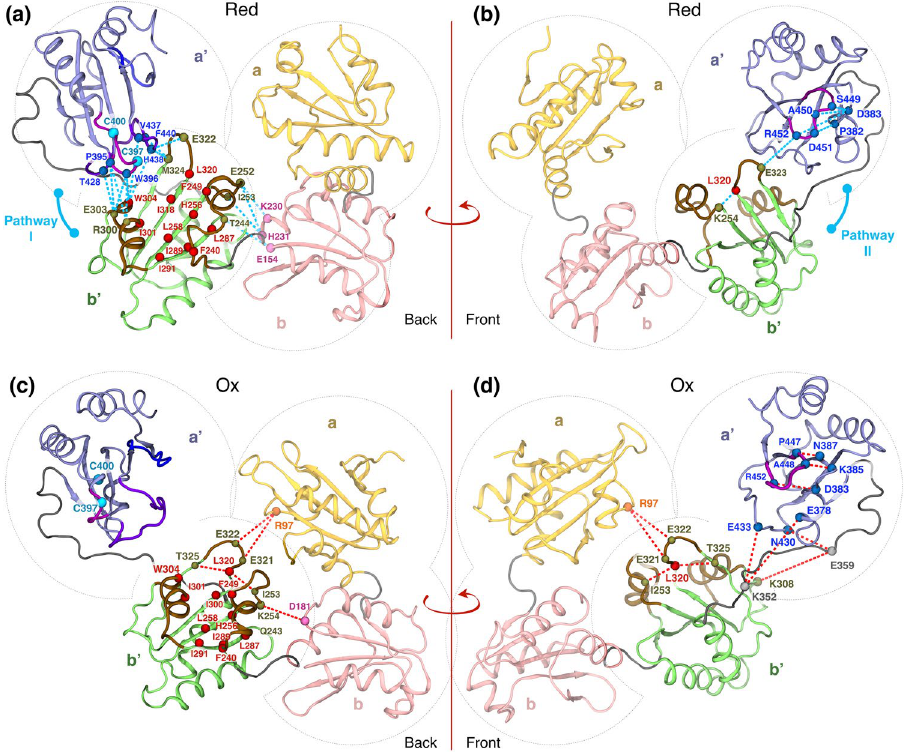
Figure 8. Red- ( a and b ) and ox- ( c and d ) dominated residue-residue interaction networks on two representative conformations of red- and ox-hPDI (C3 and C6 of FEL) between the b’ and a’ domains. Residues (C α ) within the hydrophobic pocket in each state are colored in red. Red and blue dash-lines indicate the ox- and red-dominated interactions, respectively. Secondary structures involve in formation of the upper edge of hydrophobic pocket are colored in brown (H9, H11 and L B14-B15 ). Secondary structures of a’ domain that contribute in b’a’ interactions are colored in violet (L B17-H15 , L B18-B19 and L B19-B20